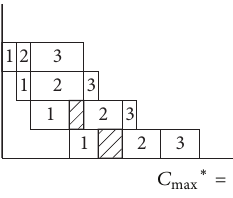
Figure 1: Optimal permutation schedule.